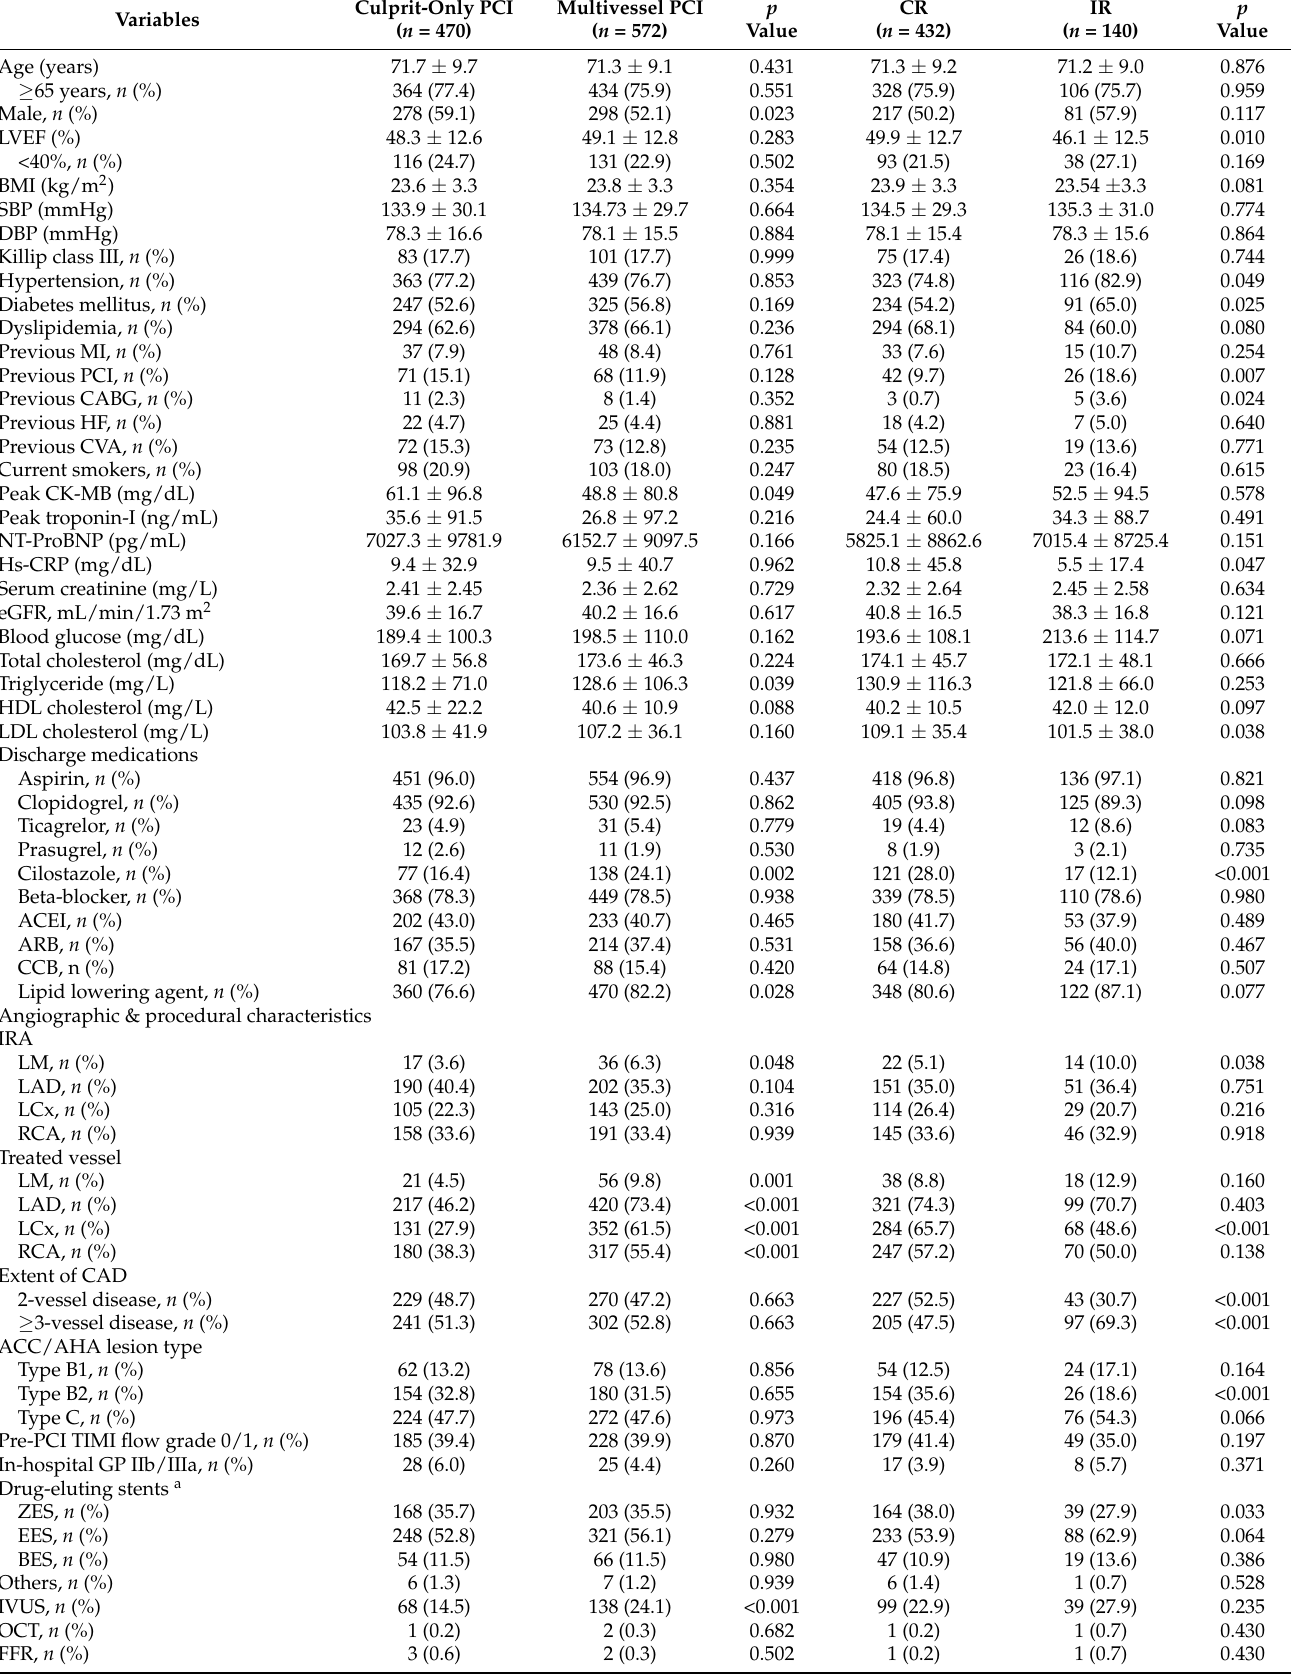
Table 1. Baseline clinical, laboratory, angiographic and procedural